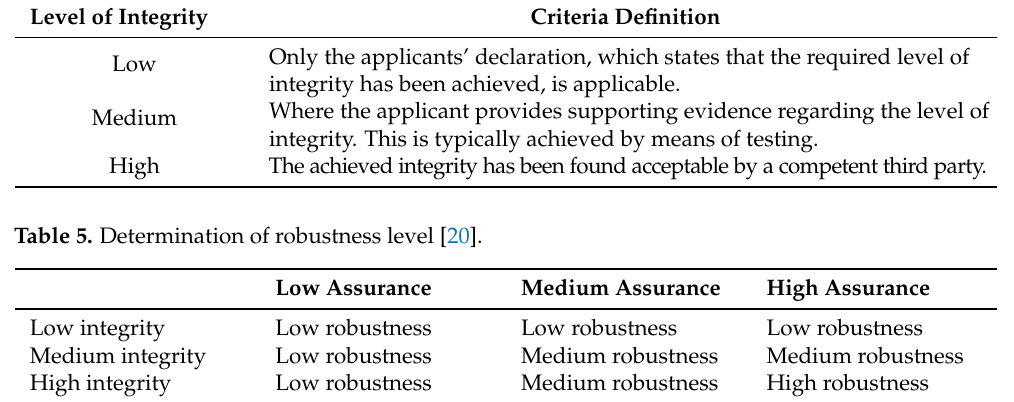
Table 4. Required criteria for integrity levels.